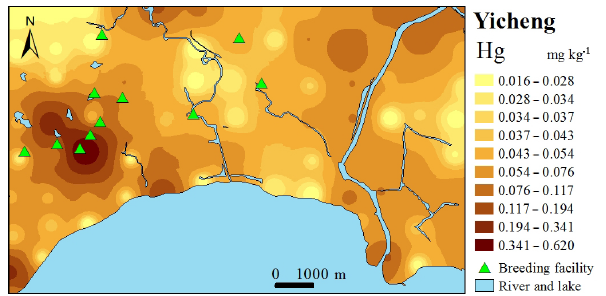
Figure 5. Filled contour map generated by inverse distance- weighted interpolation showing the spatial distribution of soil Hg concentrations in the Yicheng area (generated using the Inverse Dis- tance Weighting spatial analyst tool of the ArcGIS software pack-